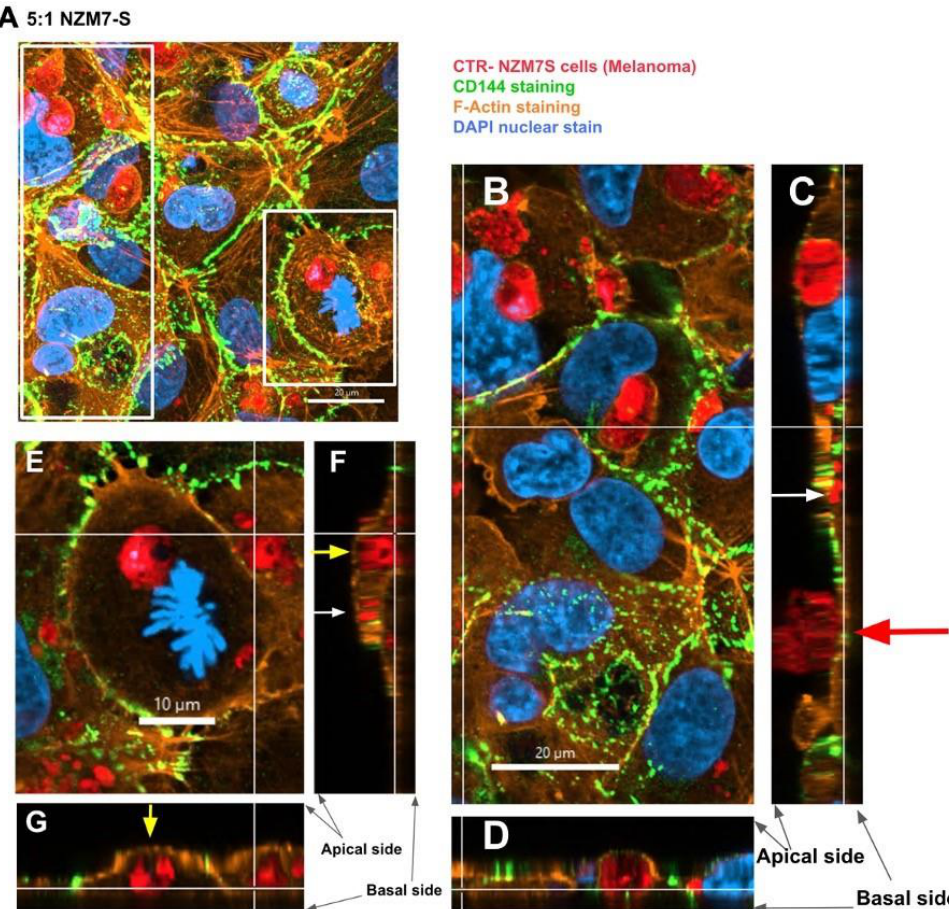
Figure 13. Confocal microscopy Z-stack image of different sized NZM7-S and their localisation. hCMVECs were seeded at 20,000 cells per well. NZM7-S were live stained with CytoTrack Red (CTR) and applied to the apical face of a confluent endothelial monolayer. Samples were analysed by confocal laser scanning microscopy. ( A ) The xy-stack of NZM7-S added at an E:T ratio of 5:1. Boxed regions are magnified to the right of, (long, left box) and below (short, right box) image A. ( B ) The xy-slice at the level of the basal white lines on ( C , D ). ( C , D ) The z-stacks along the vertical and horizontal line, respectively, on B. ( E – G ) The same xyz stack configuration. Yellow arrows show large NZM7-S inside the endothelial cell body. White arrows show small NZM7-S encapsulated by actin filaments of the hCMVEC. Red arrow shows NZM7-S cell positioned on the apical surface of the endothelial cell body. Images acquired using a Zeiss LSM 800 Airyscan confocal microscope.